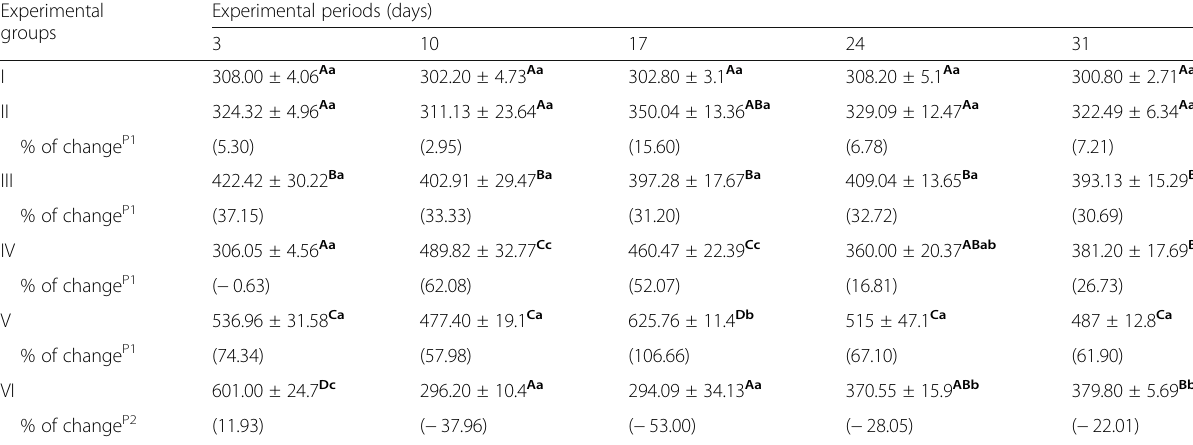
Table 6 Plasma levels of IL-6 (pg/ml) in the experimental groups at the experimental periods Experimental